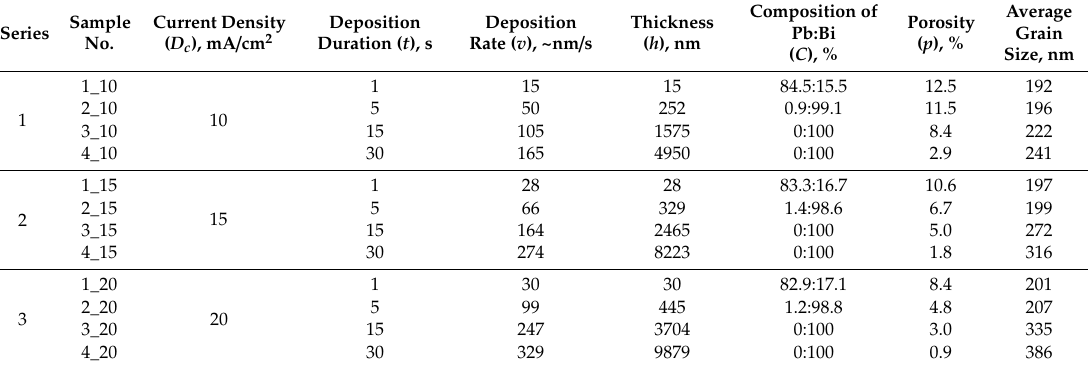
Table 1. The description of synthesis conditions and parameters of the main experimental samples. Sample Series